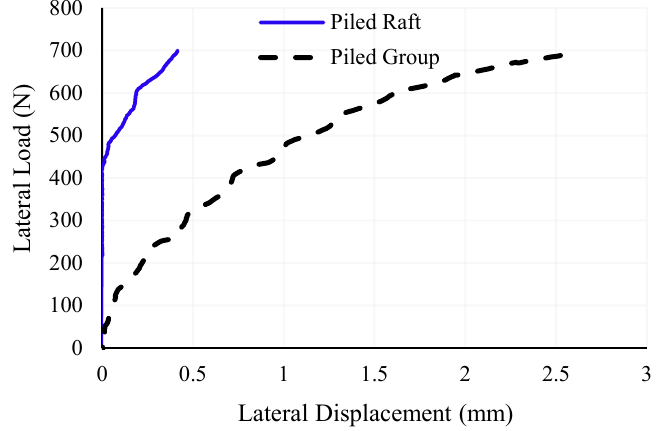
Figure 24. 13-piled raft vs. 13-pile group response under lateral load.